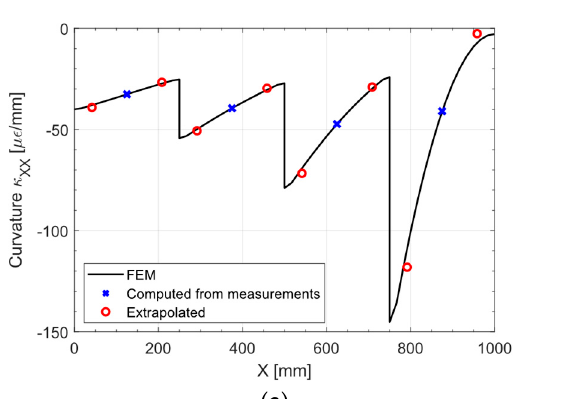
Figure 14 . Uniform pressure: normalized curvature 𝜉 (cid:3025)(cid:3025) pre-extrapolation.